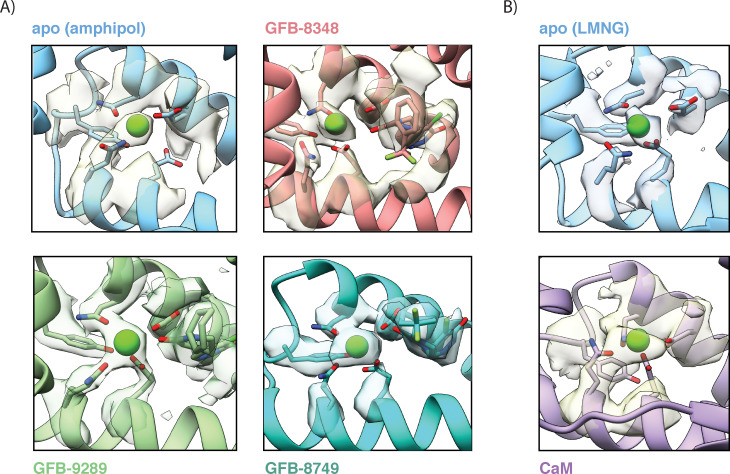
Ca2+-binding site in the VSL domain of apo and ligand-bound TRPC4.(A) Close-up view of the Ca2+-binding site in apo and ligand-bound TRPC4 determined in amphipols. The coordinating residues in the Ca2+ ion binding site and the modelled Ca2+ ion are shown in stick and sphere representation along with their densities. The oxygen atom of the ligand molecules is situated close to the bound Ca2+-ion (refer) Figure 4C (B) Close-up view of the Ca2+-binding site in apo and TRPC4-CaM complex determined in presence of lauryl maltose neopentyl glycol (LMNG). The external addition of Ca2+ ion during the TRPC4-CaM complex preparation reflects its strong density. The different structural forms shown in (A) and (B) are color coded and named accordingly.